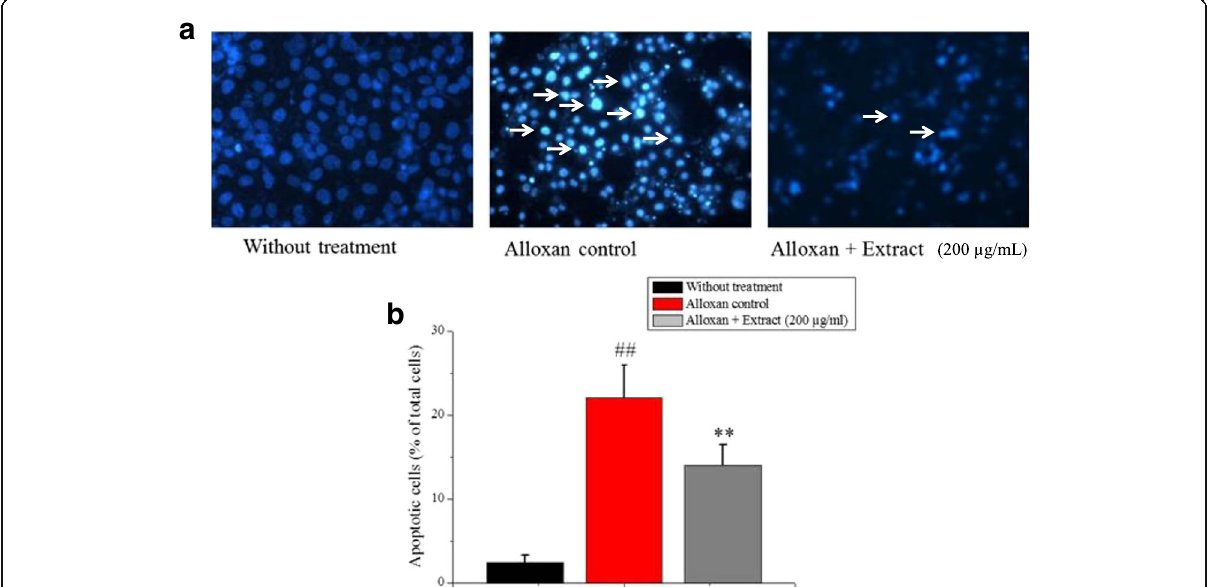
Fig. 6 Protective effects of C. crepidioides extract on the cell survival in alloxan-treated INS-1 cells by Hoechst 33,342 staining method. a Representative images by Hoechst 33,342 staining, arrowheads in the pictures indicate the nuclei of the apoptotic cells (Hoechst-positive cells). b The apoptosis rate was determined by calculating the percentage of Hoechst positive cells over the total number of cells. Values were represented as mean ± SD from three independent experiments. ## p < 0.01 as compared with the control group; ** p < 0.01 as compared with the alloxan control group. Apoptosis activity results for INS-1 cell line induced with 200 μ M of alloxan and pre incubated with different concentrations of